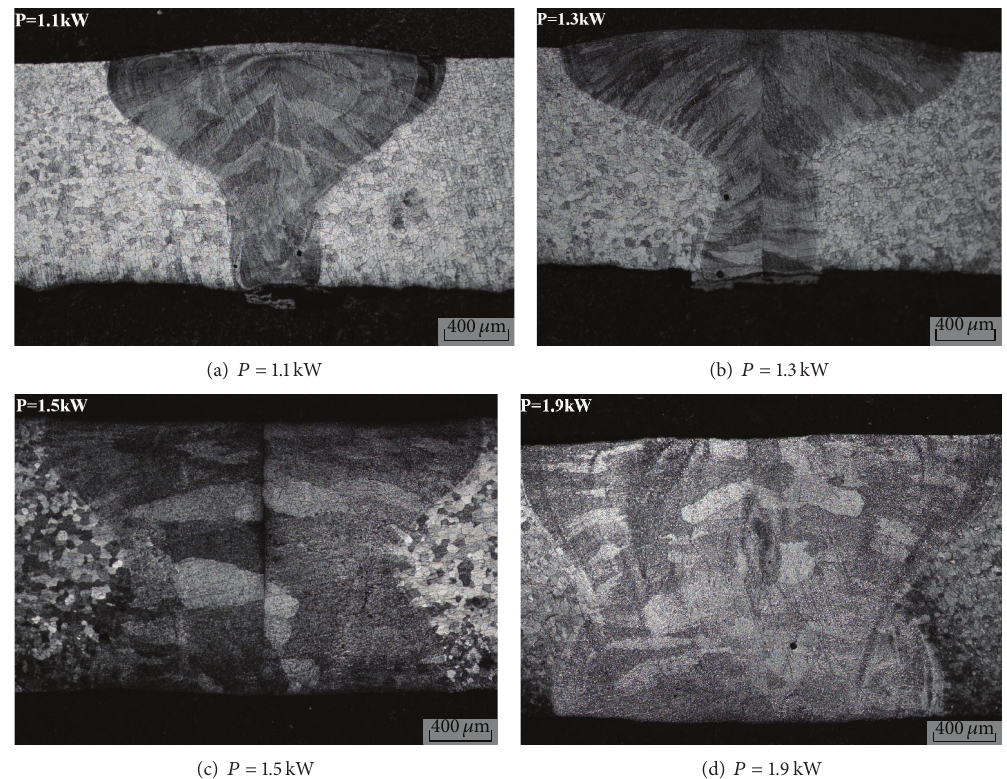
Figure 1: Influence of laser output power on cross-section morphologies of welded seam. ( Δ𝑍 = 0 mm; 𝑉 = 1.5 m/min; 𝑈 𝑓 = 15 L/min).